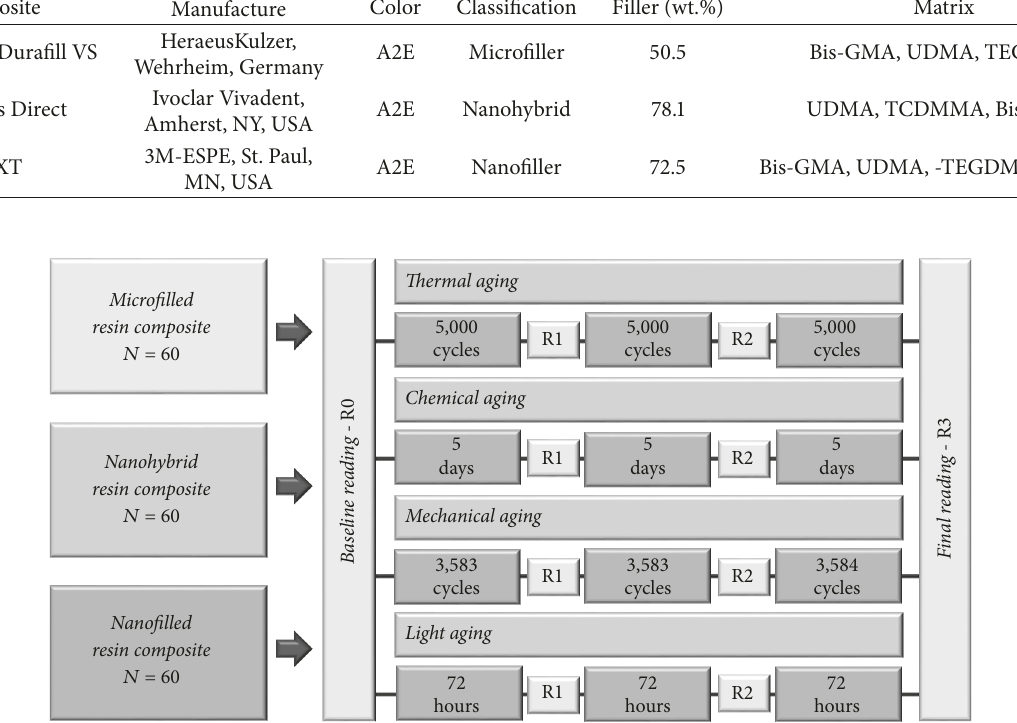
Figure 1: Schematic diagram of experimental design of this